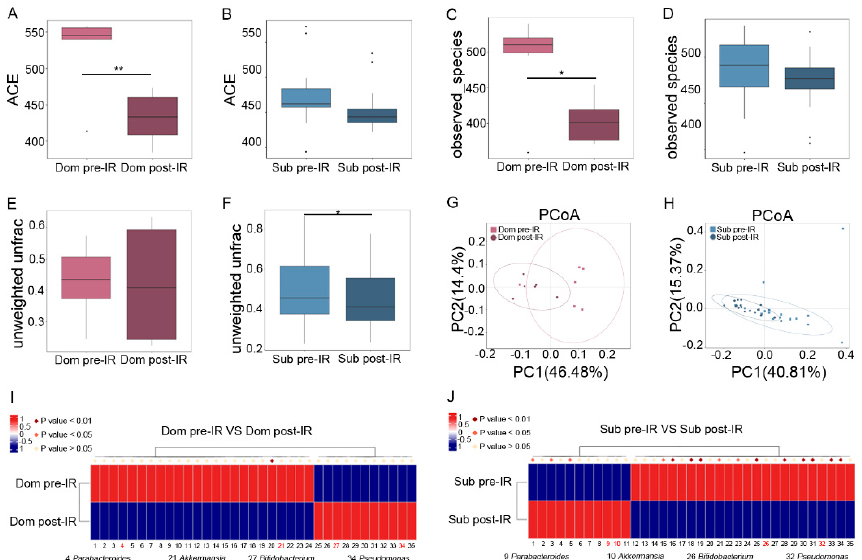
Figure 2. Irradiation affects characteristic gut microbiota signatures in Dom and Sub mice. The α − diversity of enteric bacteria of Dom and Sub mice before and after radiation was compared by ( A , B ) ACE index and ( C , D ) observed species. The β − diversity of enteric bacteria of ( E ) Dom mice and ( F ) Sub mice was compared by unweighted unifrac analysis. ( G , H ) PCoA was applied to examine the alteration of intestinal bacteria taxonomic patterns. ( I ) Differences of gut microbiota in Dom mice before and after 13 Gy TAI. ( J ) Differences of gut microbiota in Sub mice before and after 13 Gy TAI. Details of the bacteria are listed in Supplementary Table S3. Statistically significant differences are indicated: Student’s t test, n = 6 in Dom pre − IR and Dom post − IR groups, n = 18 in Sub pre − IR and Sub post − IR groups, * p < 0.05 and ** p < 0.01.